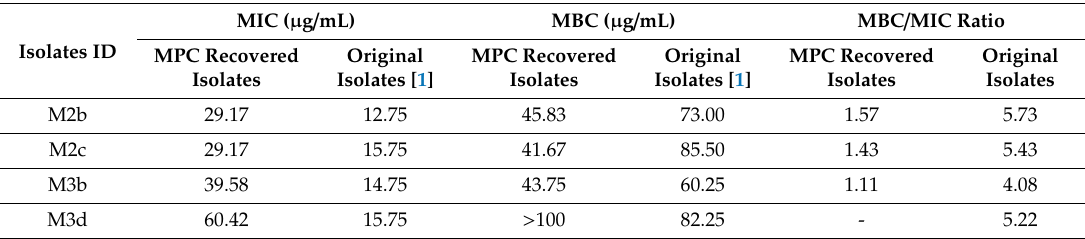
Table 3. MIC, MBC, and MBC / MIC ratio of nisin regarding the enterococci collection recovered after MPC protocol and the original enterococci collection obtained from the oral cavity of dogs with